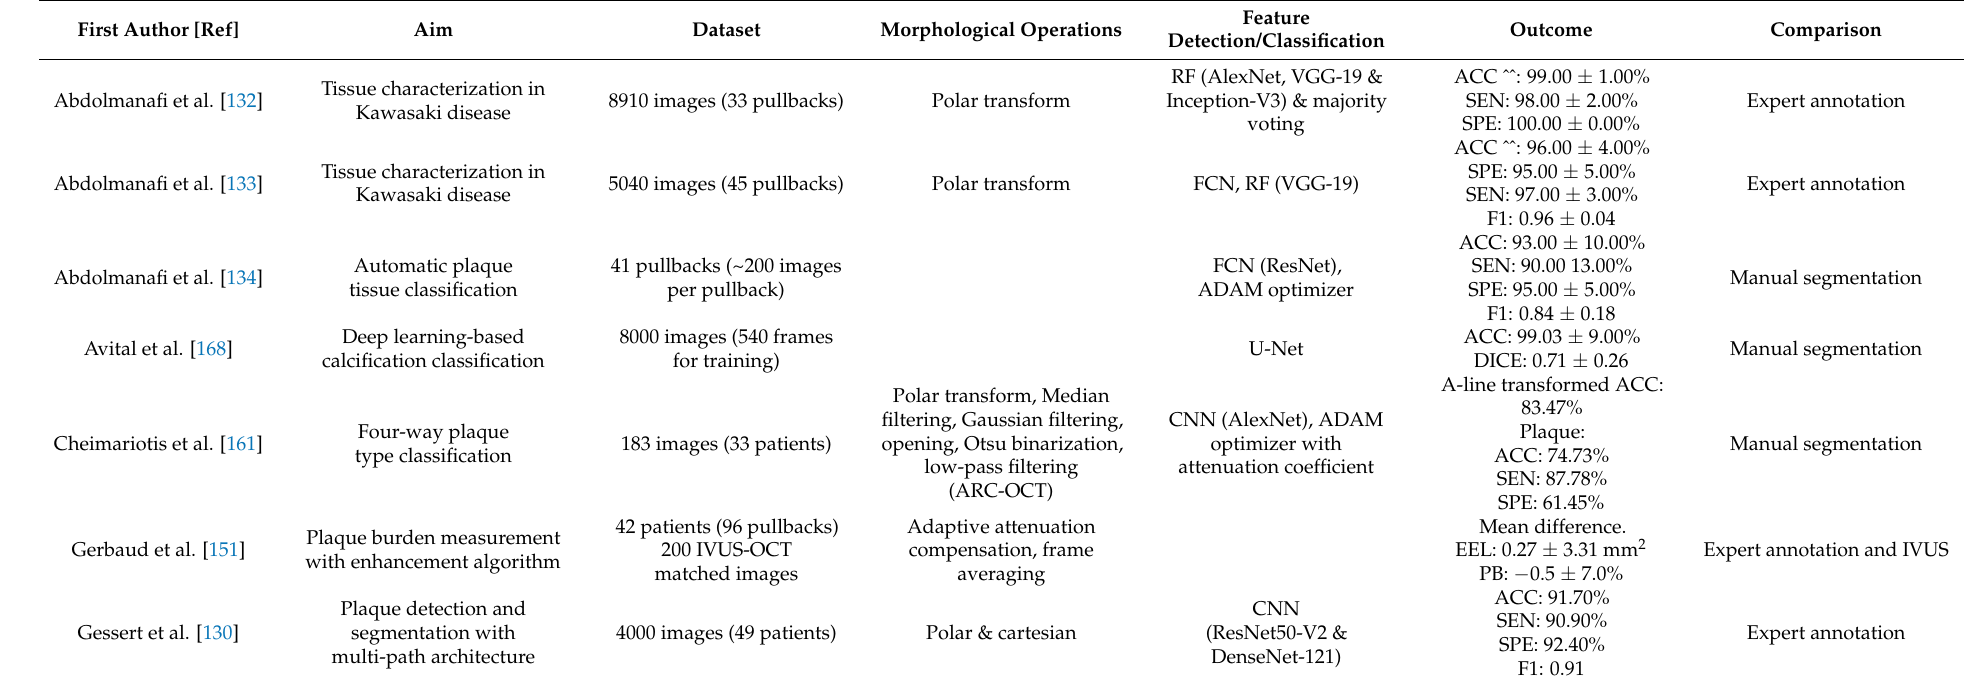
Table A3. Classified articles investigating automated plaque classification and segmentation. ACC—Accuracy. ADAM—Gradient based adaptive optimiza- tion. AFPDEFCM—Fourth-order PDE-based fuzzy c-means. ANN—Artificial neural network. AP—Average precision. AUC—Area under the curve. CNN— Convolutional neural network. CRF—Conditional random field. DA—Data augmentation. DB—Dual binary classifier. DICE—Dice loss coefficient. EEL—External elastic lamina. F1—F1-score. FC—Fibrocalcific plaque. FCM—Partial differential equation-based fuzzy c-means. FCN—Fully convolutional network.